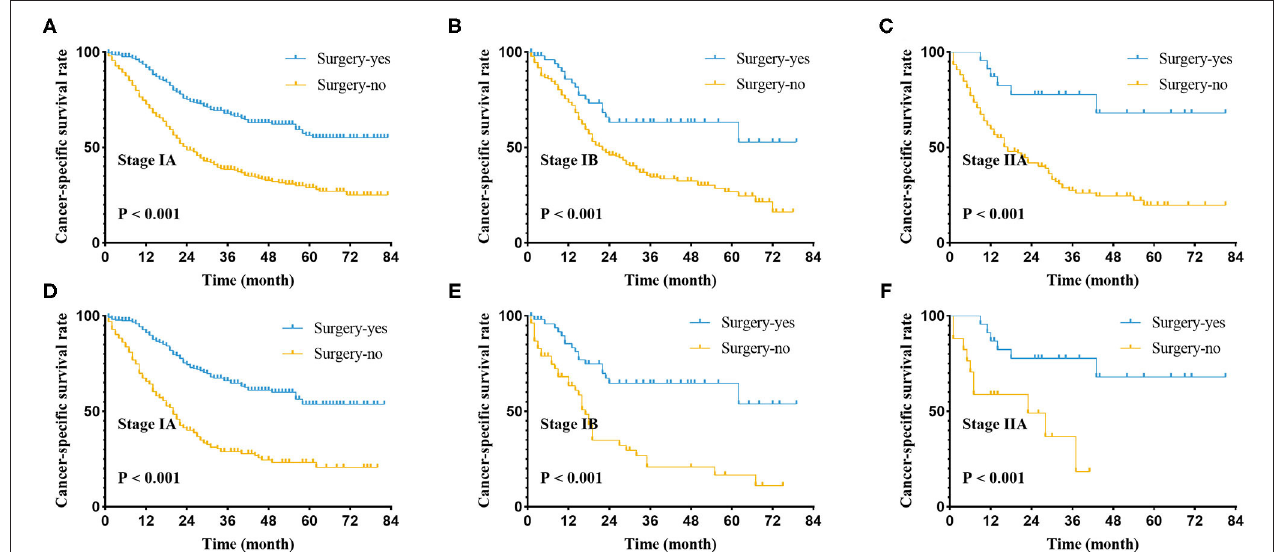
FIGURE 2 | Cancer-specific survival curve for stage I-IIA small cell lung cancer patients with according to the treatment approach in the unmatched cohort (A–C) and matched patients (D–F) of pathological stage.